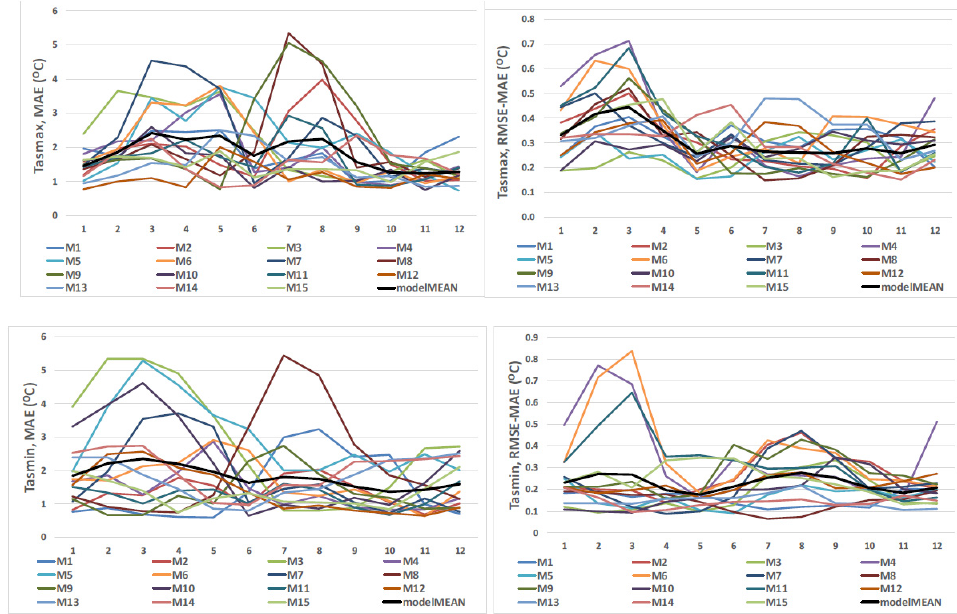
Figure 2. Validation metrics for tasmax ( upper left and right ) and tasmin ( bottom left and right ), EURO-CORDEX simulations (full name of individual models are given in Table 1) against ROCADA observation-derived datasets, over the period 1971–2000. Table 2. Validation metrics for tasmax, tasmin, and pr: multimodel mean of 15 EURO-CORDEX simulations against ROCADA observation-derived datasets, over the period 1971–2000. Variable/Metric